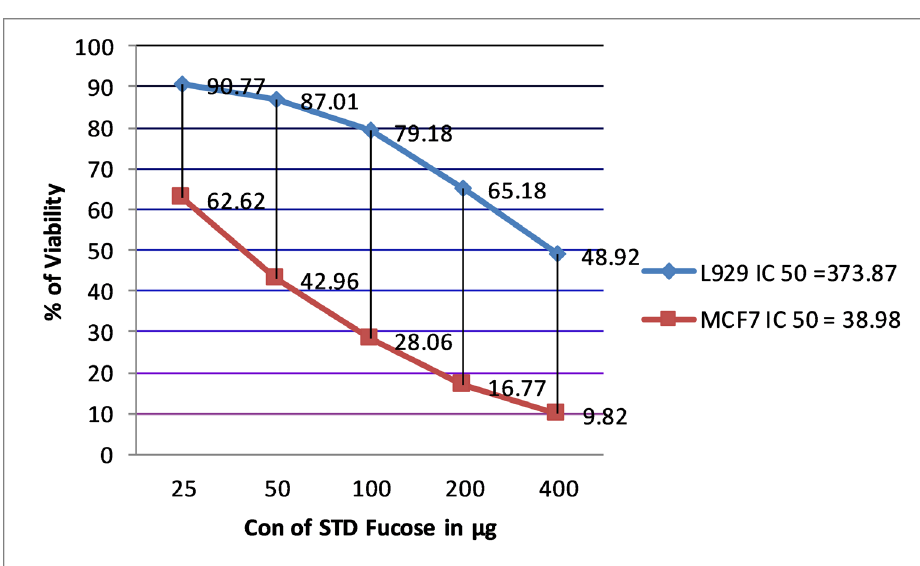
FIGURE3 -St andard fucose treated with MCF7 breast cancer cell line and normal Fibroblast cell line L929.The graph shows the concentration of standard fucose at 25, 50, 100, 200, 400 µg/ml against the percentage of viability against MCF7 cancer cell line and L929 Normal cell line for 24 hours of incubation at 37°C. The graph represents that, the percentage of cell viability of the MCF7 Breast cancer cell line decreases intensively with the increase in the concentration of the standard fucose with the IC50 value of 38.98µg and IC50 value of 373.87µg for L929 normal mouse fibroblast cell